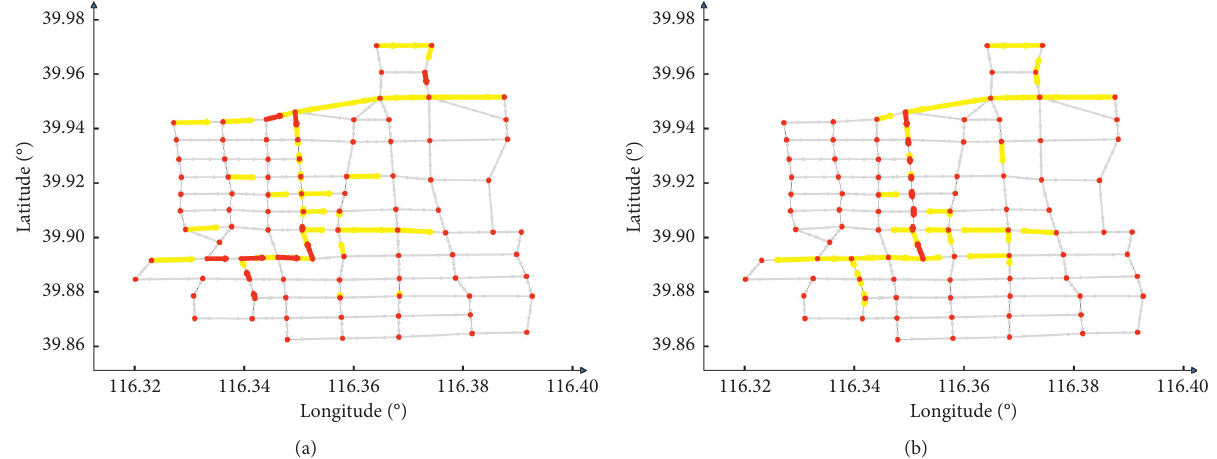
Figure 9: Identification results of key roadway sections in peak hours on Monday. (a) 7:00–9:00. (b) 17:00–19:00.